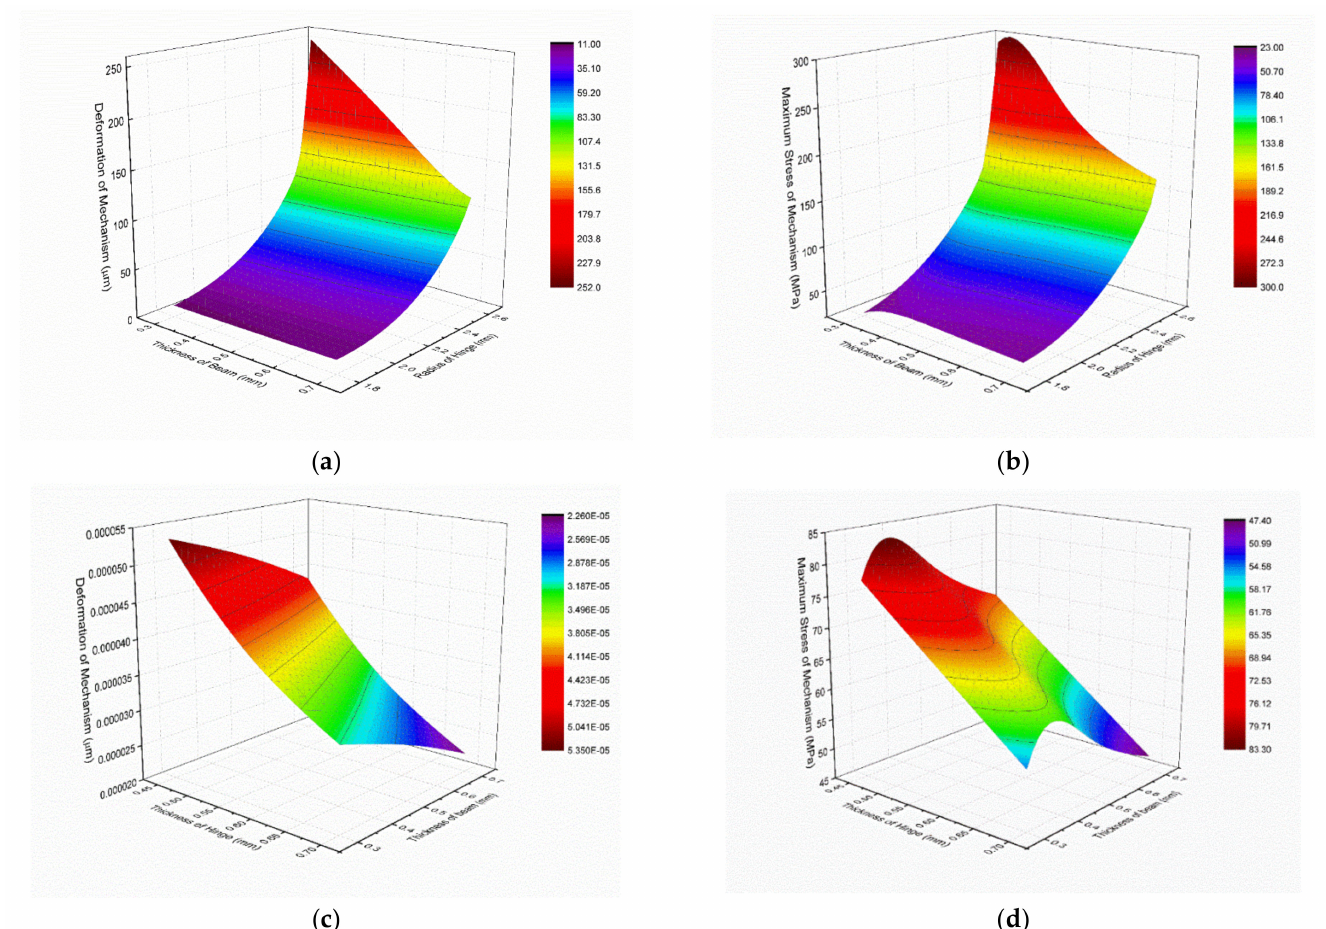
Figure 9. Relationship between structural parameters and output displacement/maximum stress. ( a ) Deformation versus thickness of beam and radius of hinge; ( b ) Maximum stress versus thickness of beam and radius of hinge; ( c ) Deformation versus thickness of hinge and beam; ( d ) Maximum stress versus thickness of hinge and